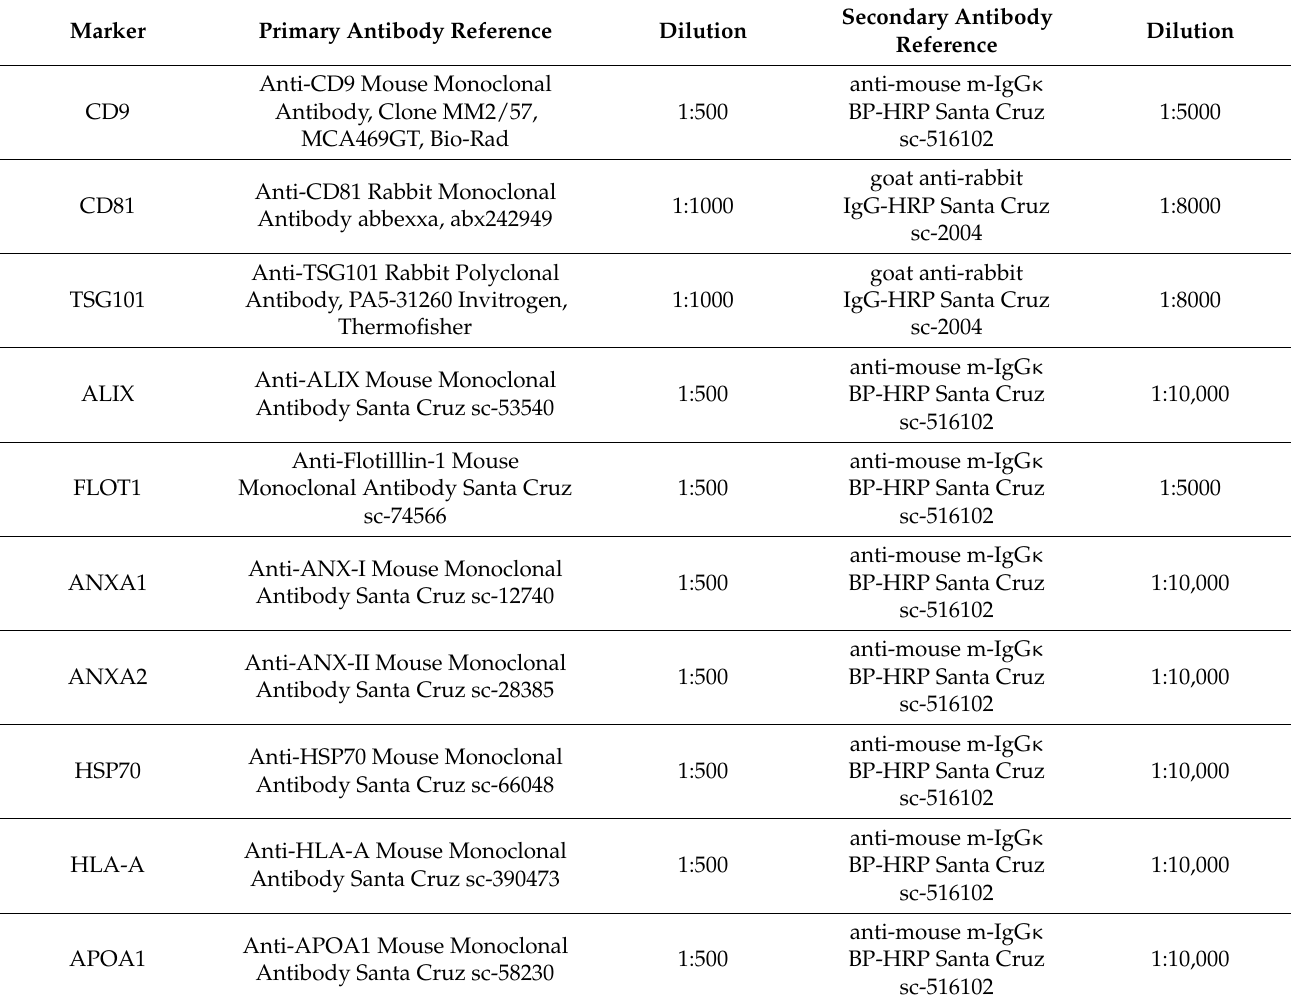
Table 2. Antibodies and dilutions used for Western Blotting